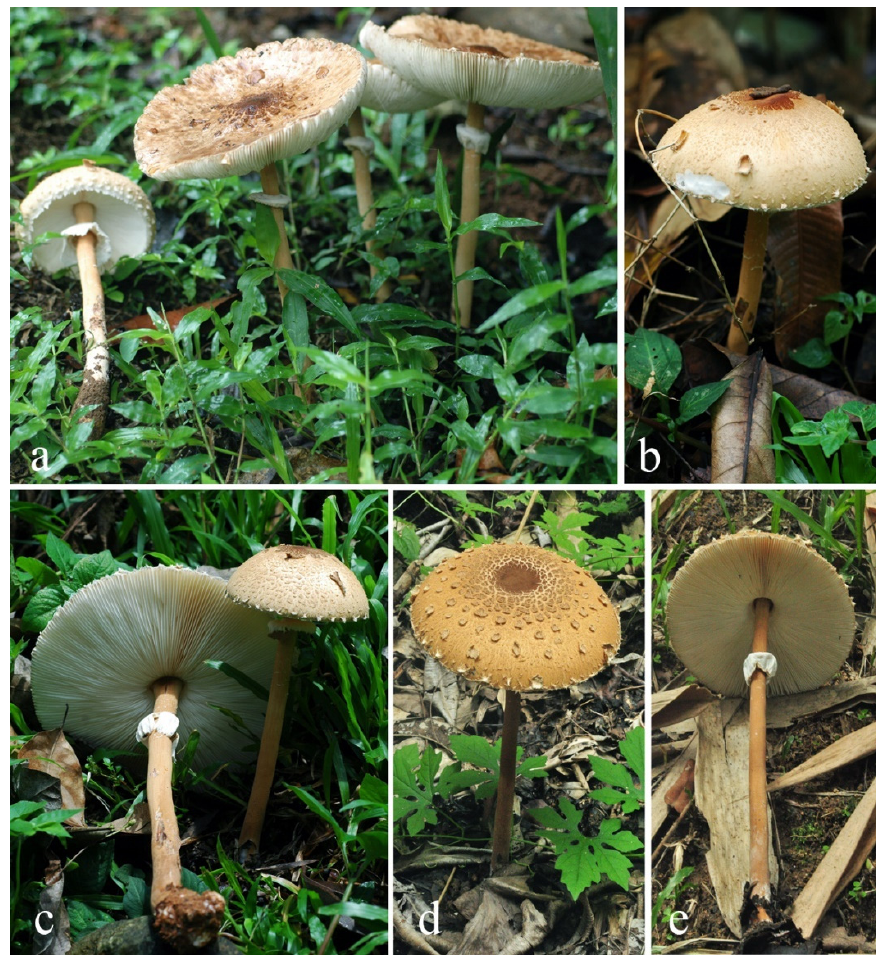
Figure 19. Fresh basidiomata of Macrolepiota excelsa in situ. ( a ) MFLU 09-0203. ( b ) ecv3553. ( c ) ecv3572 (type). ( d , e ) HNL501921.